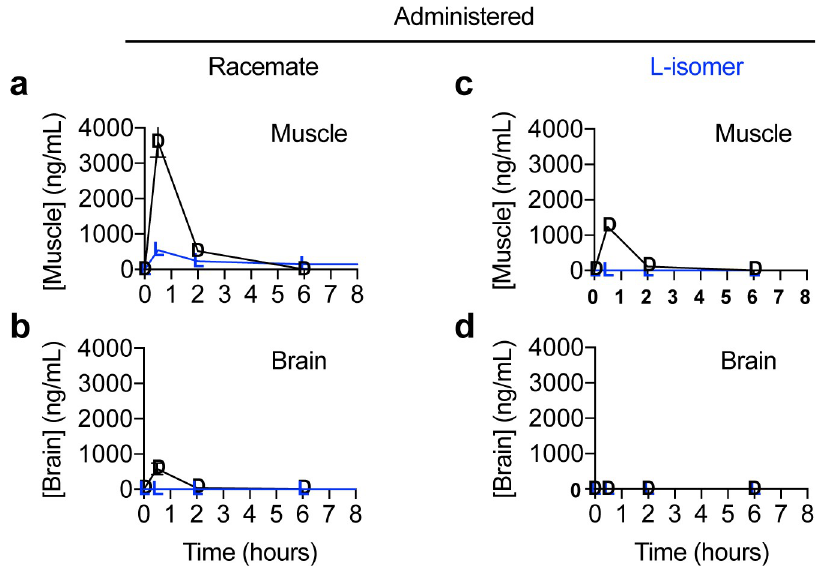
Fig 6. Graphs of the concentration of enantiomers in tissue versus time after administration of racemic N-acetyl- DL-leucine or purified N-acetyl-L-leucine. Data are for ( a,b ) muscle and ( c,d ) brain and presented as linear-linear plots. Values are the mean ± standard error of the mean with n = 3